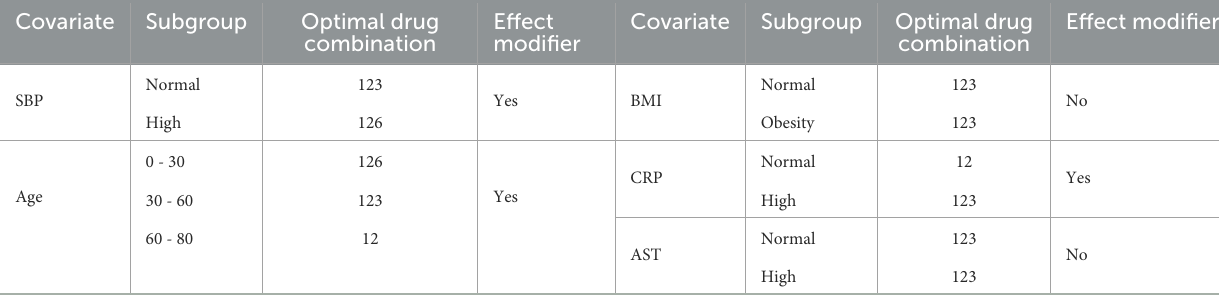
TABLE 3 Selecting effect modifiers among age, SBP, BMI, CRP, and AST.